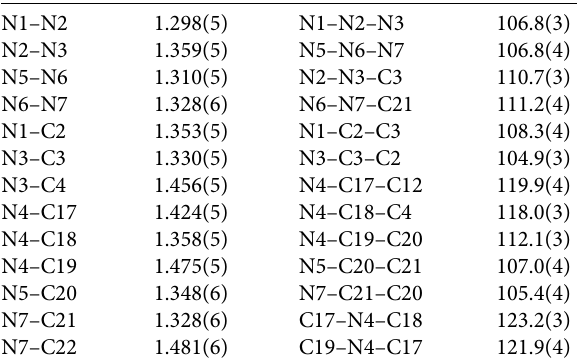
Table 5. Selected bond lengths (Å) and angles (°) for compound 12d · 2CDCl 3 .